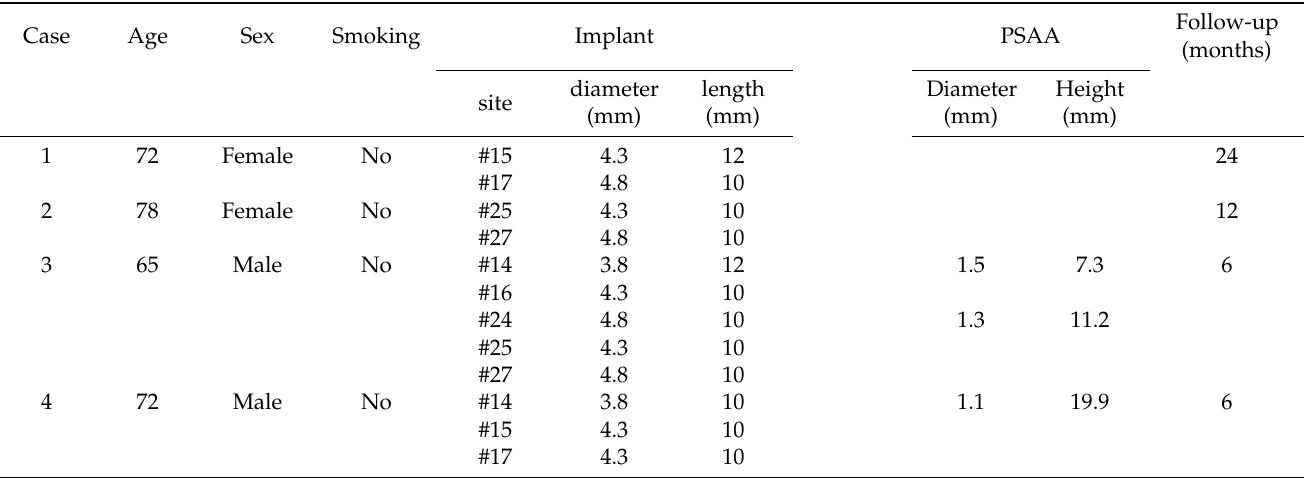
Table 1. Demographic characteristics of the patient, site and implant information, and information of posterior superior alveolar artery and